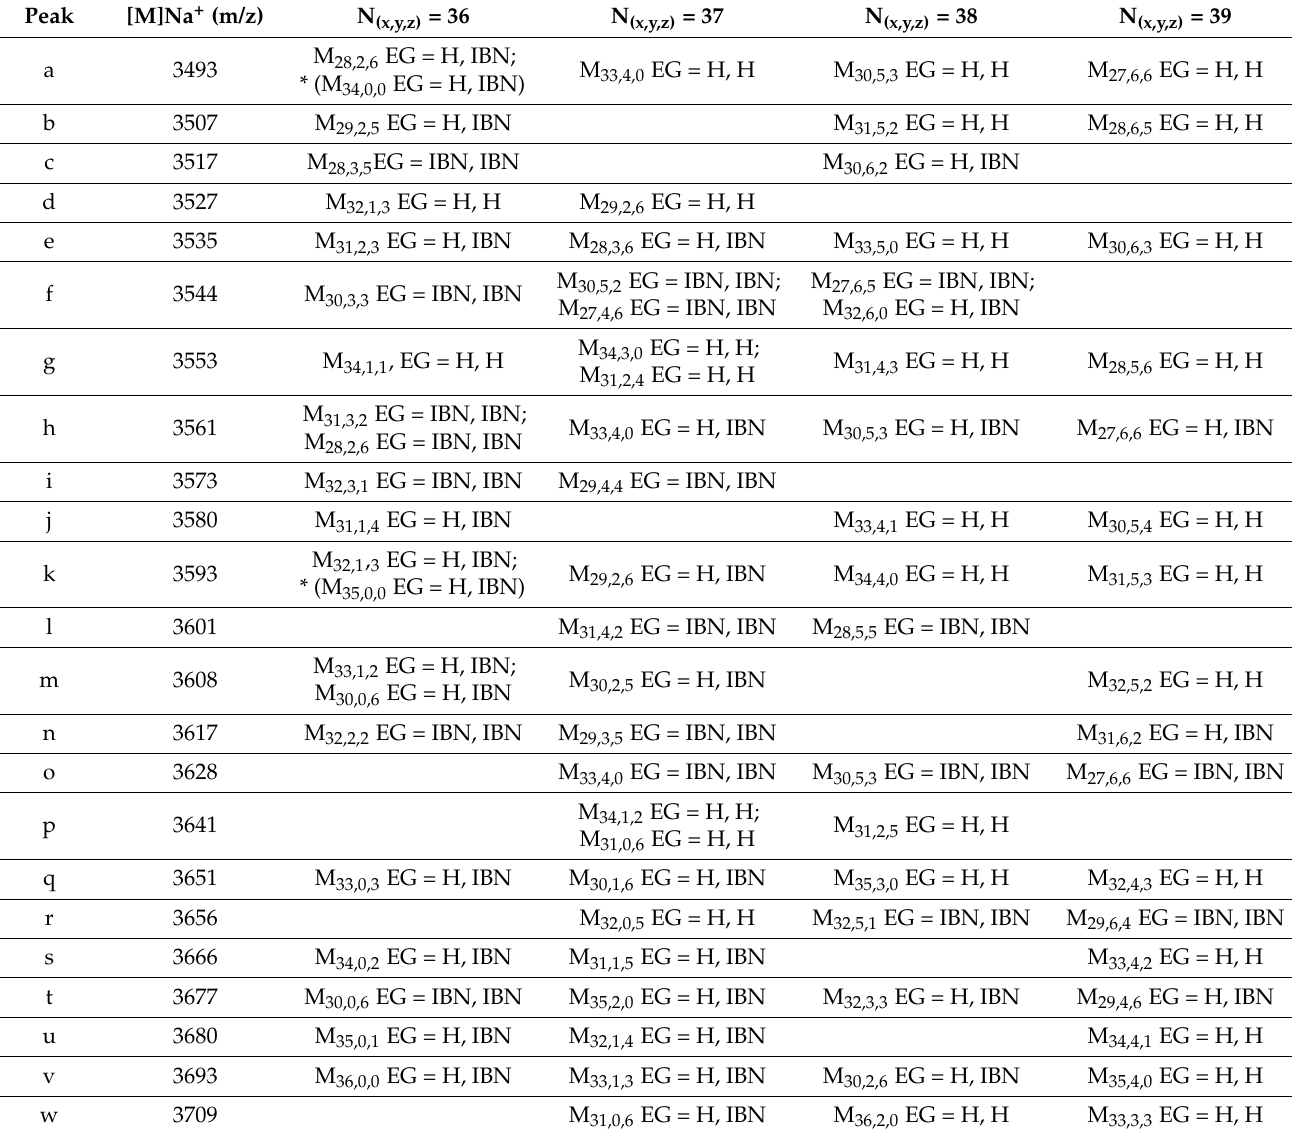
Table 2. Table reassuming the repeating units’ composition of the bombarded